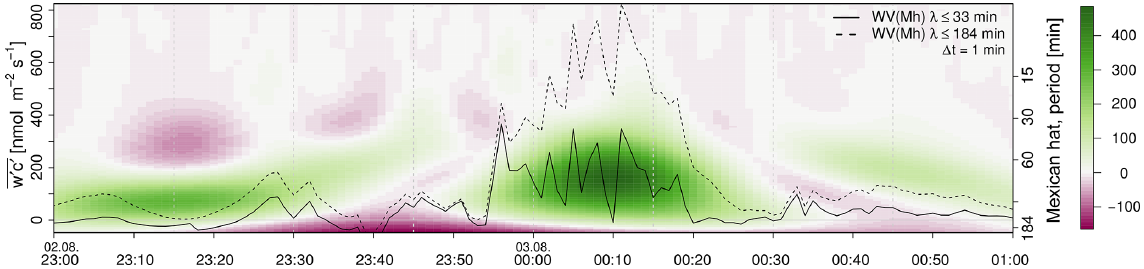
Figure 5. Mexican hat wavelet cross-scalogram for the case study event on 2–3 August 2014 at tower 1. The right axis numbers the period, while plotted lines refer to the left axis. Solid lines show the flux for an integration over all periods from λ = 2 · δt to λ = 33min (Mh: Mexican hat), while the dashed line gives the flux up to λ = 184min. The colours in the wavelet cross-scalograms between w and c denote the flux intensity, where intensive colours indicate higher flux contributions downwards (negative, dark red) or upwards (positive, green).